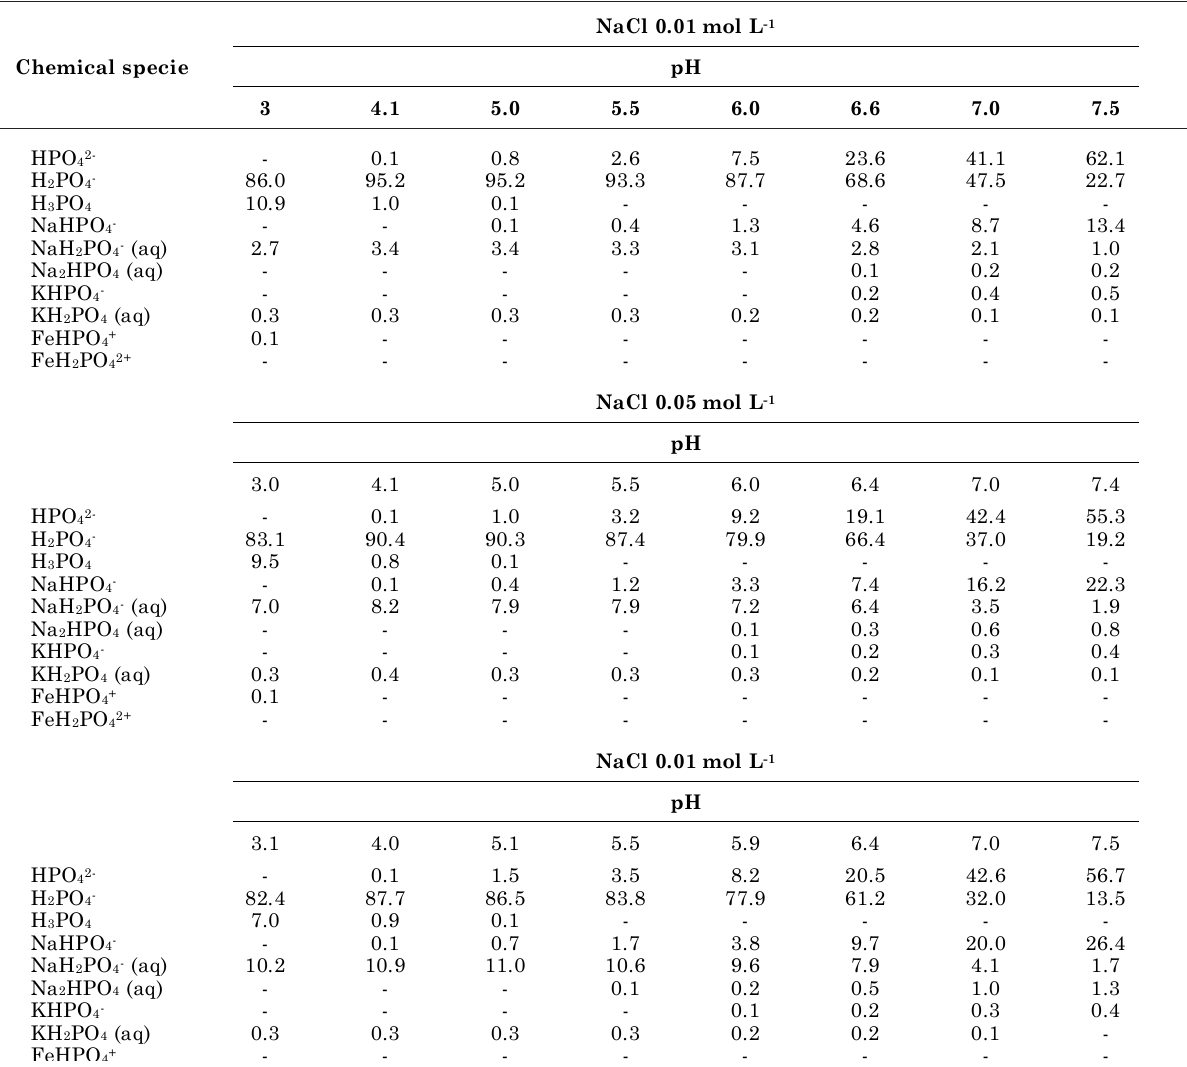
Table 2. Relative distribution of chemical species of P present in solution from the hydrolysis of the H14- syn, as a function of pH and NaCl